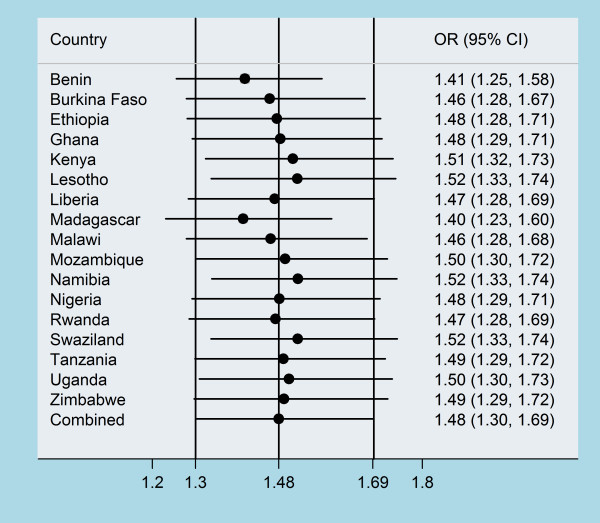
Plot indicating the influence of each country on the overall pooled result- "leave-one-country-out" sensitivity analysis.